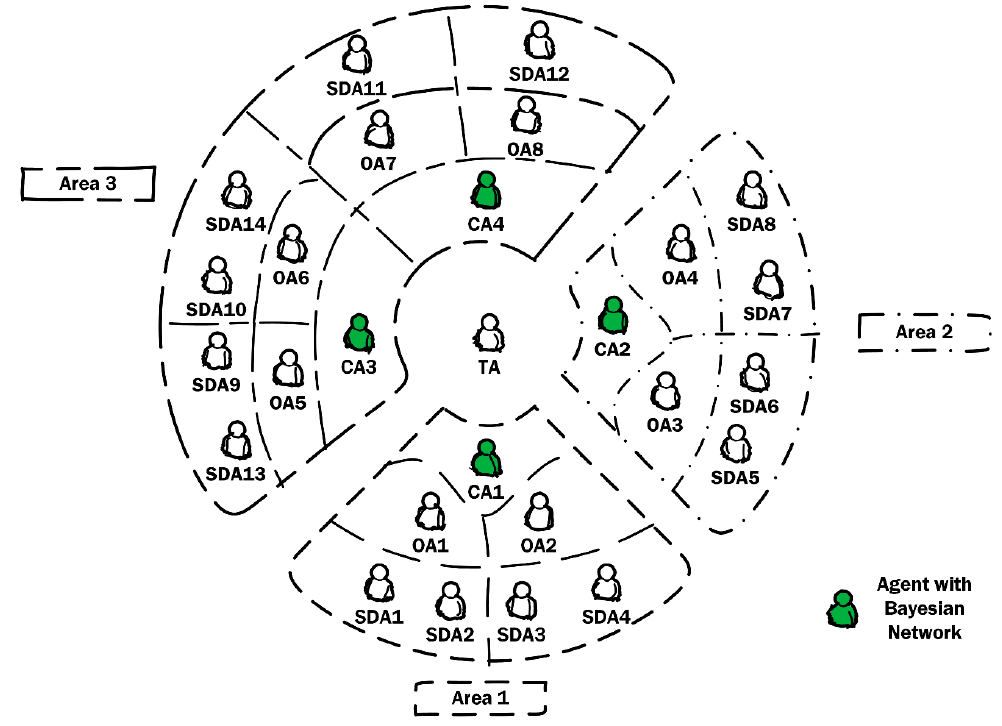
Figure 5. Testing scenario for the CARISMA system.